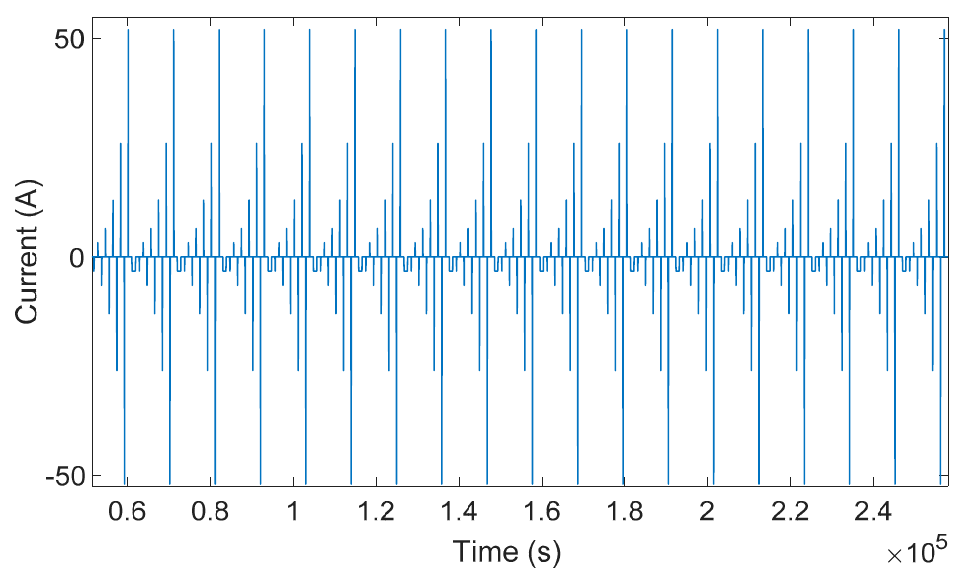
Figure 6. Charging and discharging current pulse profiles.